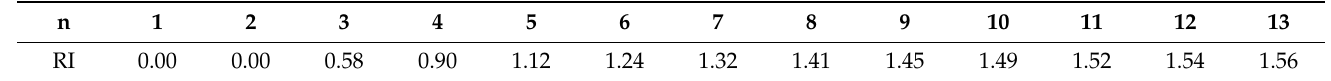
Table A1. Standards of the average random consistency index.